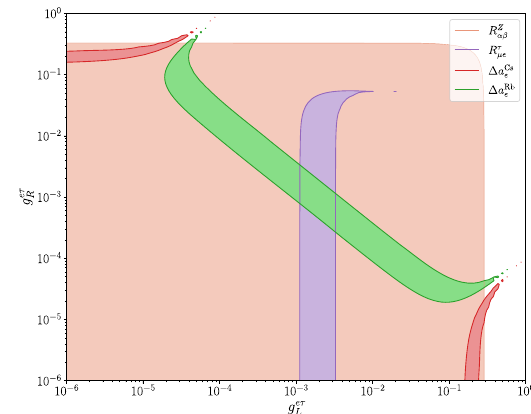
parameter space L , R